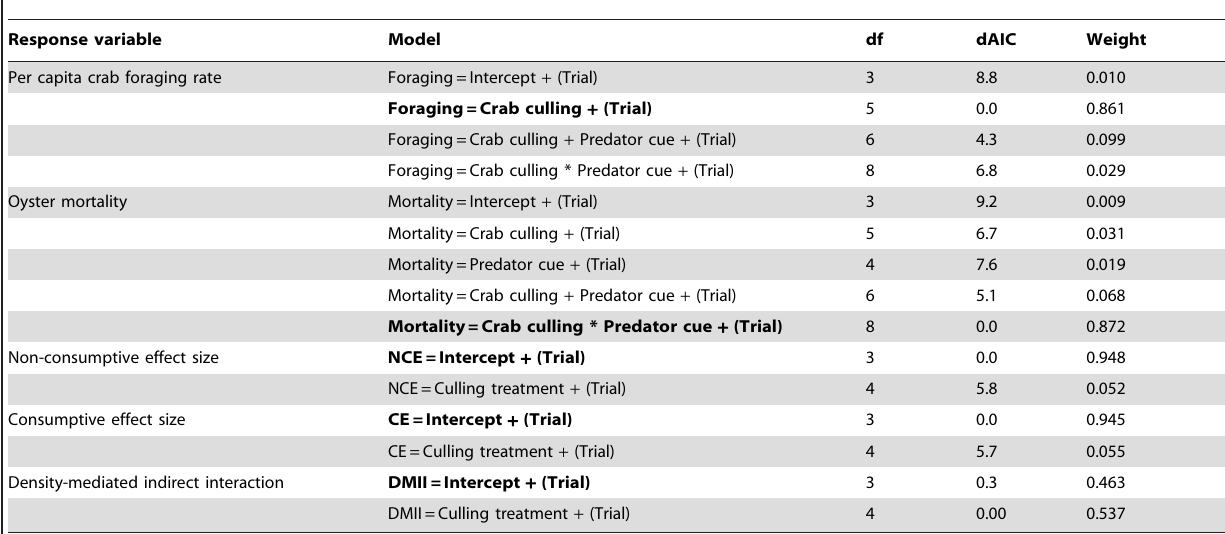
Table 1. Results of nested linear mixed-effect models for Experiment